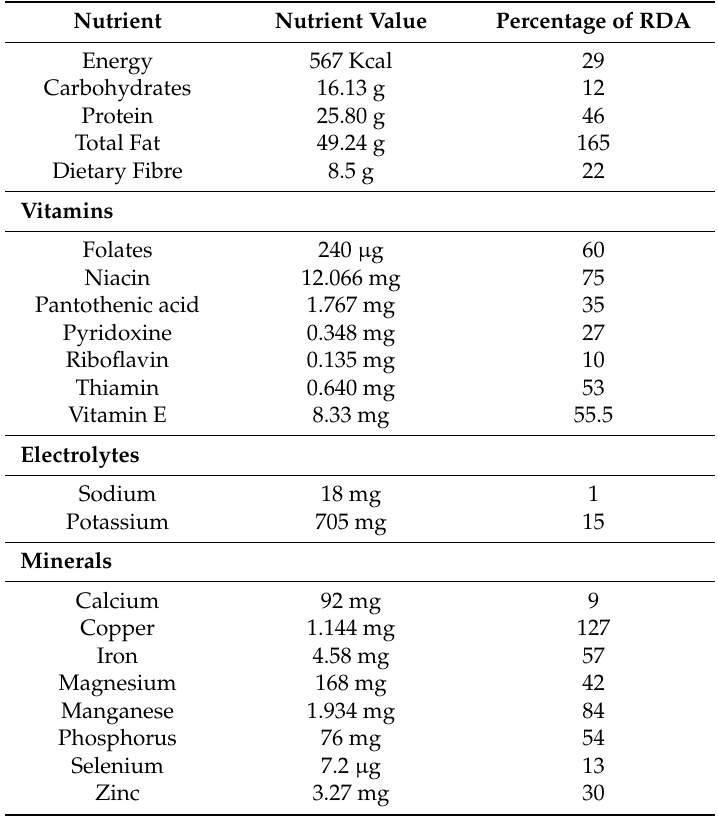
Table 1. Nutritional value of peanuts per 100 g (adapted from Arya et al.